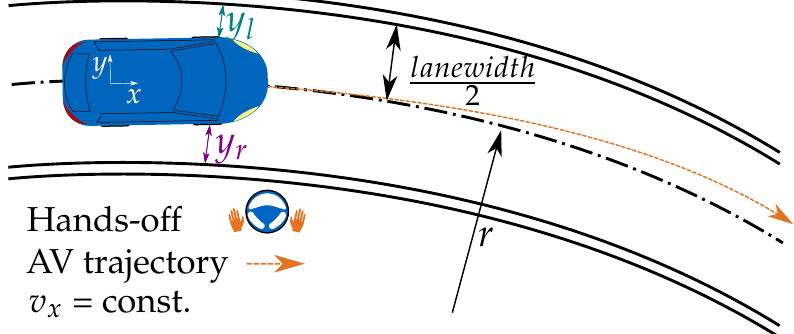
Figure 1. Schematic overview of the Lane-Keeping Functional